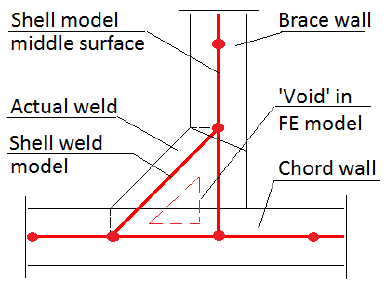
Figure 5. "Shell" FE models weld seam.